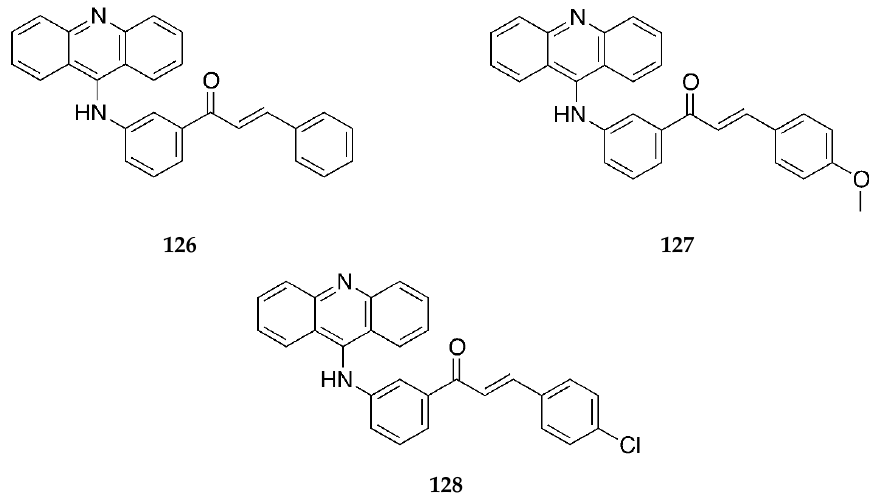
Figure 50. Chemical structures of 3-aminochalcones derivative chalcones with an acridinyl group.